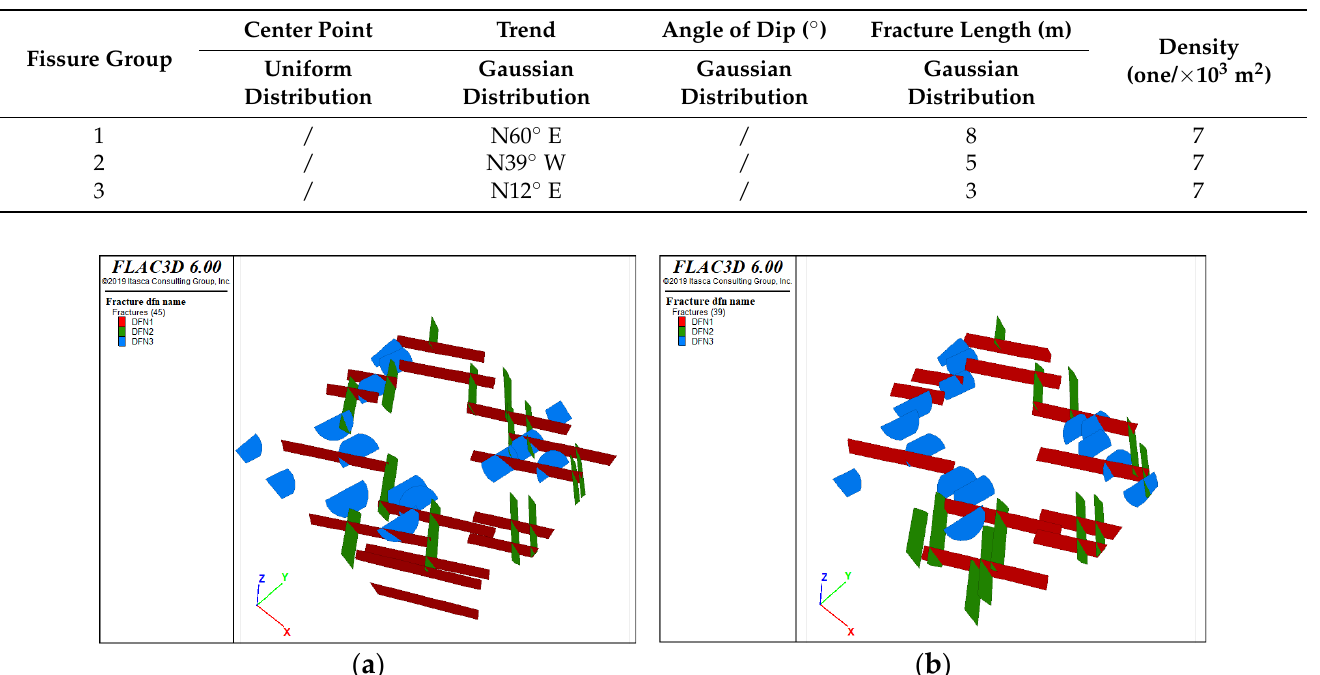
Table 2. Field revealed fracture group parameters.